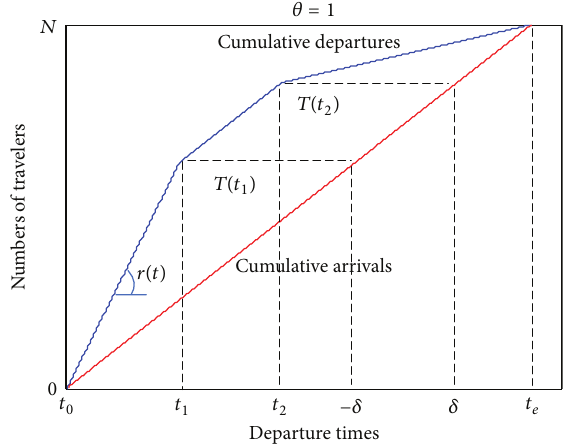
Figure 1: Departure time distributions in the deterministic case.